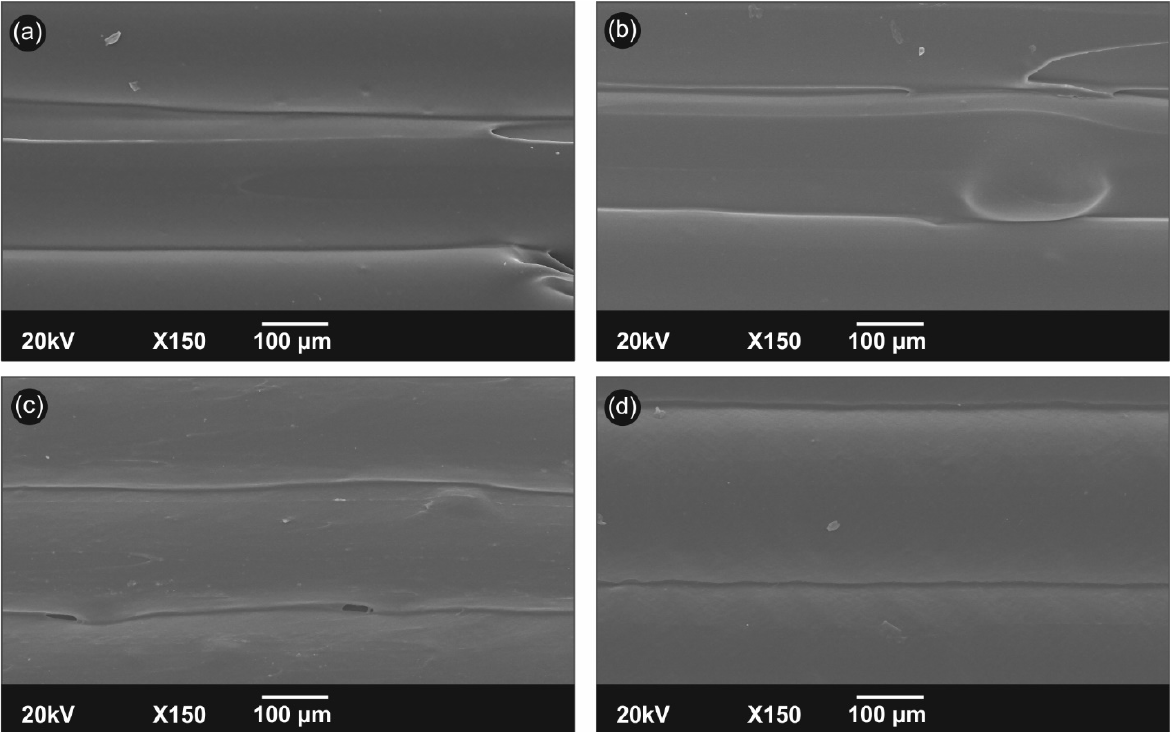
Figure 6. Side surface morphology of PA12/CB 3D ‐ printed nanocomposites: neat PA12 ( a ), compared to 2.5 ( b ), 5.0 ( c ), and 10.0 wt.% ( d ) filler loading.